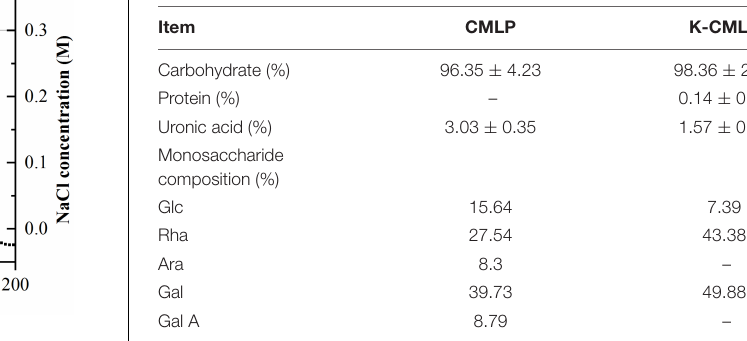
FIGURE 1 | DEAE cellulose-52 fractionation profile of polysaccharide K-CMLP.